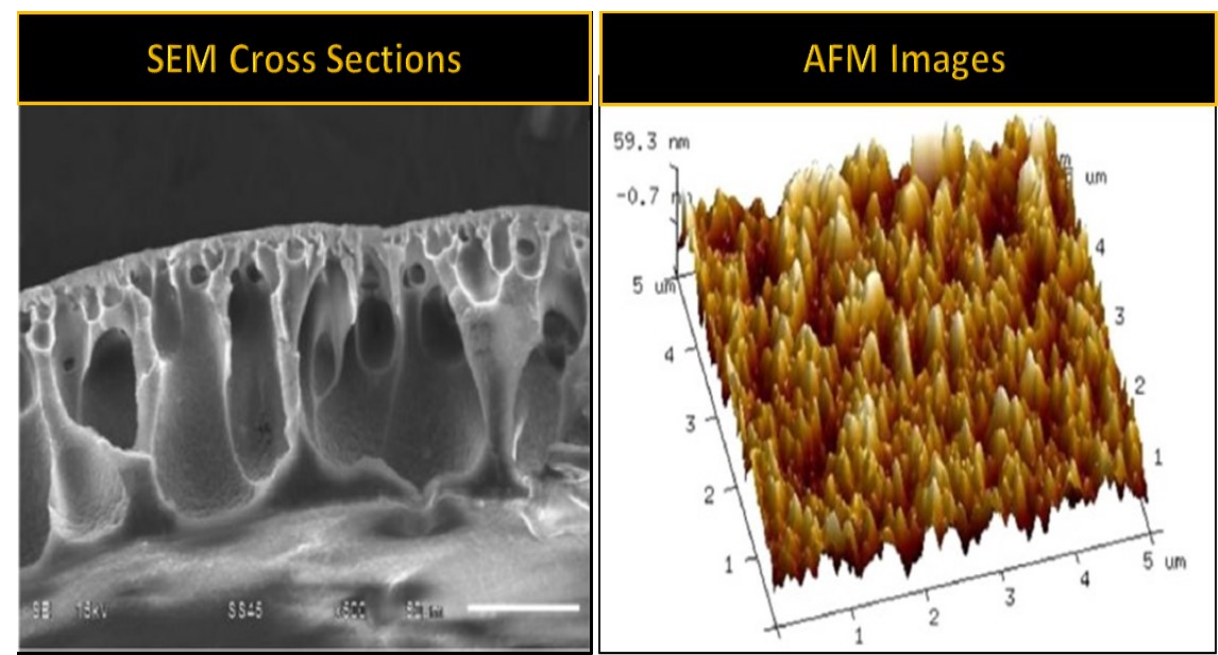
Figure 7. SEM cross sections and AFM images of the nanohybrid membrane. Reprinted with permission from ref. [47]. © 2016 Elsevier B.V.